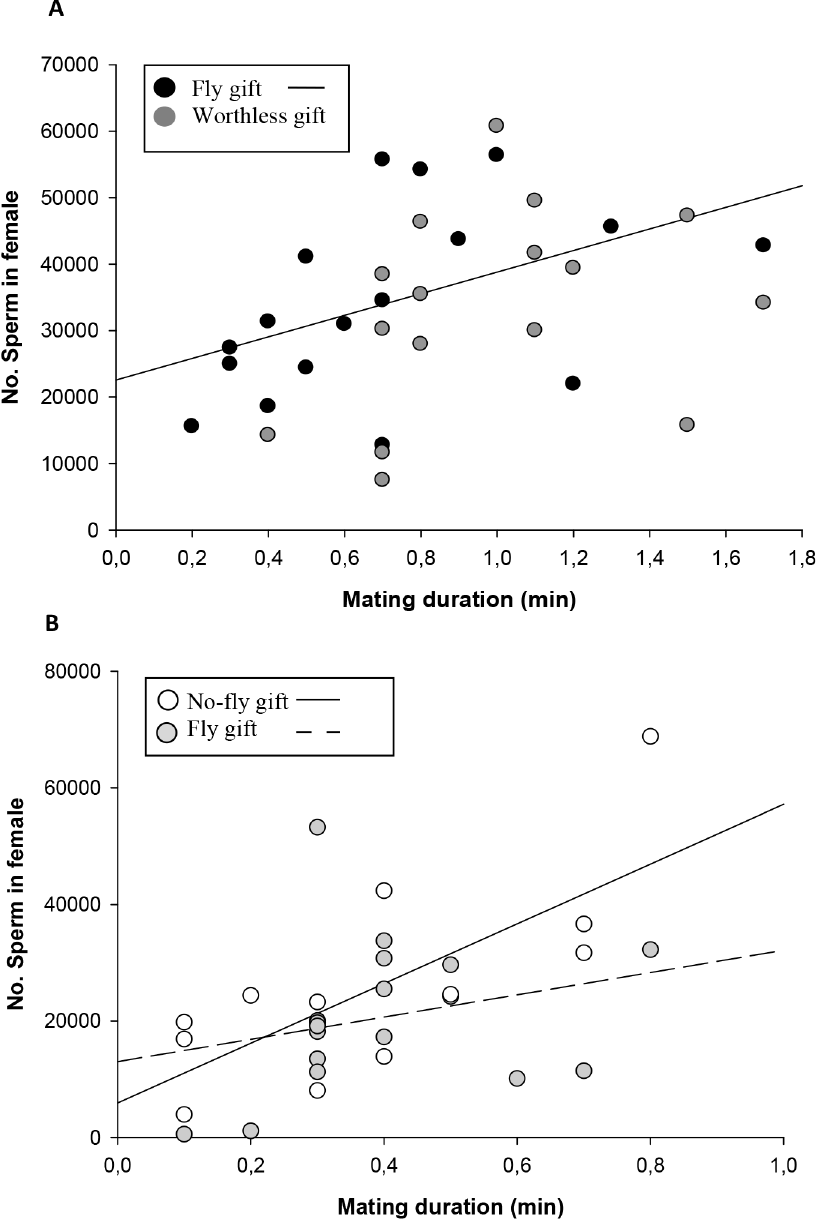
Fig 3. Linear relation between mating duration (min) and number of sperm in female spermathecae in: A) uninterrupted matings: Fly gift-uninterrupted mating, males offering a fly gift and Worthless gift- uninterrupted mating, males offering a worthless gift; B) interrupted matings: Fly gift-interrupted mating, males offering a fly gift and performing one pedipalp insertion, No-fly gift-interrupted mating, males offering no gift and performing one pedipalp insertion. P values are given in Table